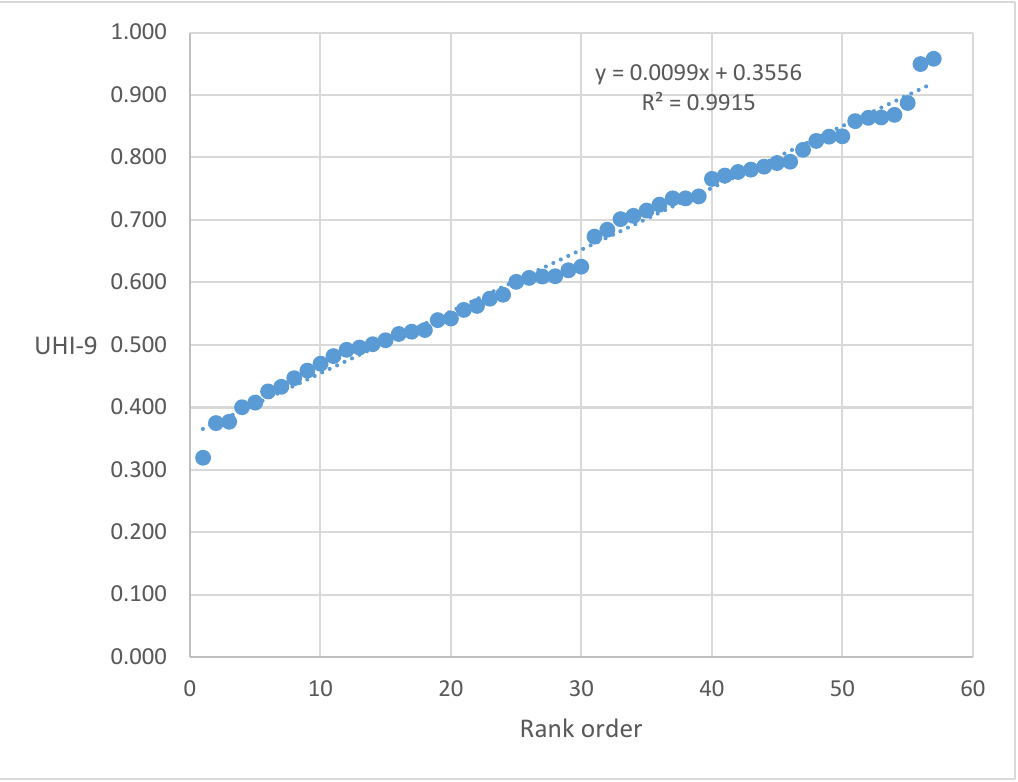
Figure 1. Scattergram of ordered Urban Health Index (UHI)-9 scores for 57 cities analyzed from Demographic and Health Surveys (DHS) data (2003 – 2013). Table 1. Summary statistics for the four Urban Health Indices that compare the 57 cities.